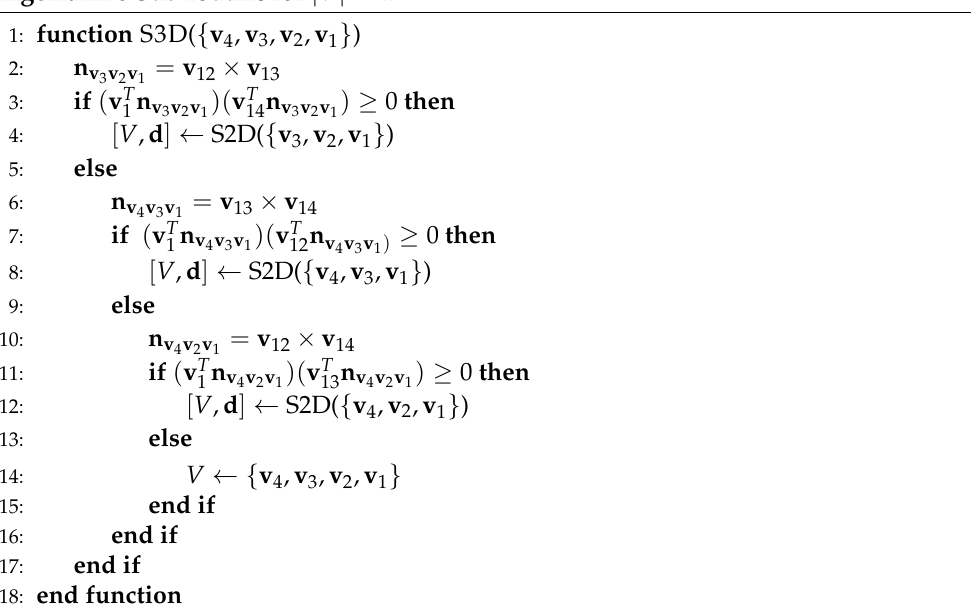
Figure 5. Examples of the closest feature of a polyhedron to a query point are shown above. Once the closest feature is obtained from Algorithm 1, the closest point, i.e., ν ( P ) , can be determined, as shown above. Algorithm 5 Sub-routine for | V | =